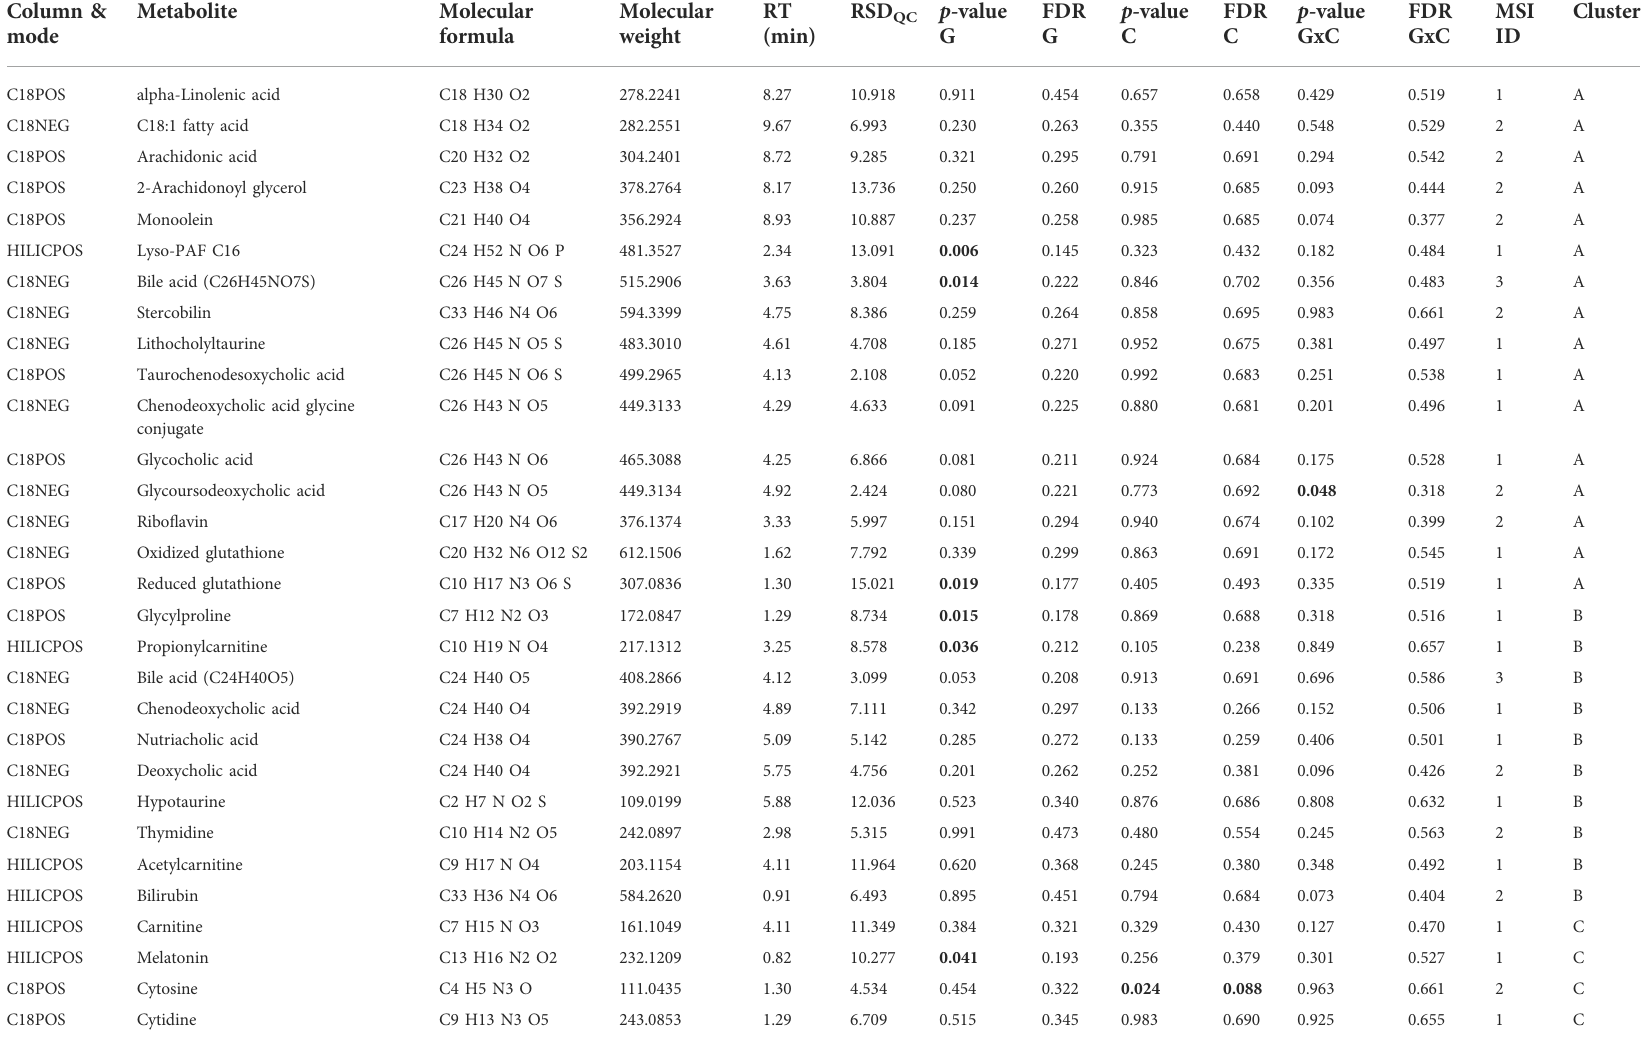
TABLE 1Summary of the metabolites identi fi ed/annotated from WT and DKI mouse plasma. A total of 83plasma metabolites were identi fi ed/annotated, including 17 metabolites signi fi cantly changed by condition (i.e., exercise versus rest) and one metabolite signi fi cantly changed by genotype (i.e., DKI versus WT) based on univariate analysis. Statistically signi fi cant values ( p < 0.05 and/or FDR < 0.1) appear in bold text.C, condition; G, genotype; G × C,interaction between condition and genotype; FDR. false discovery rate; MSI,Metabolomics Standards Initiative; RSD QC ,relative standard deviation in quality control samples; RT, retention